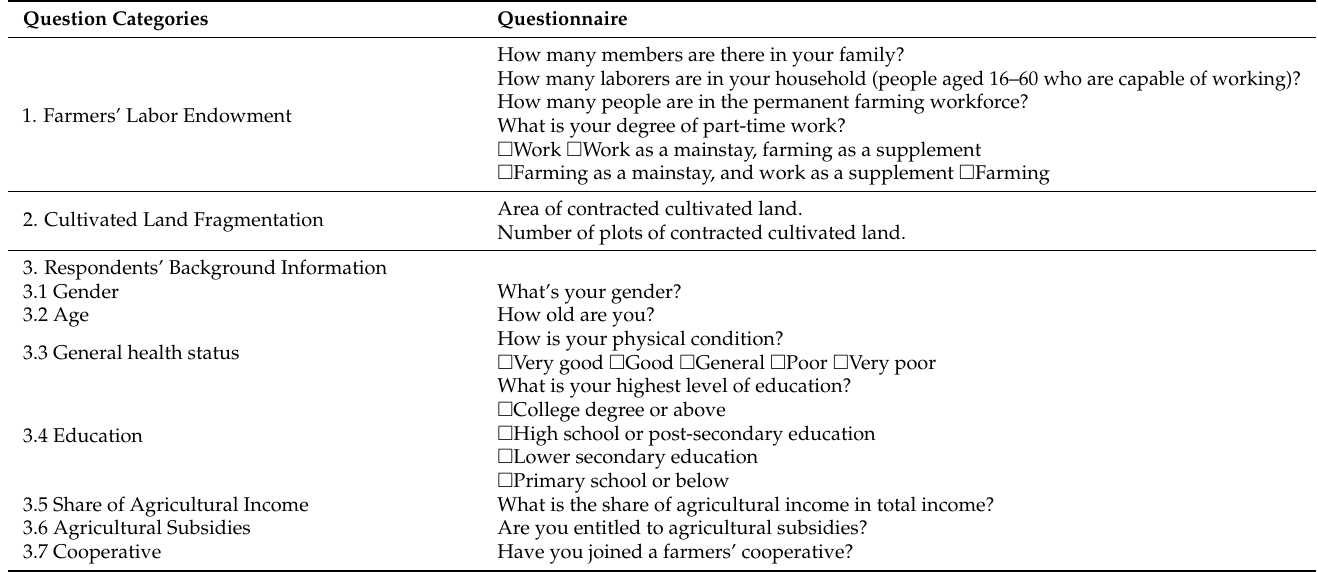
Table A1. Main structure of the survey